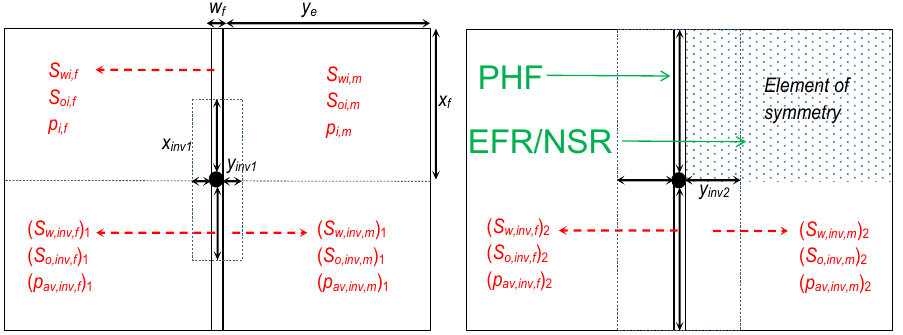
Figure 1. Conceptual model used by Clarkson et al. [12] for the tight oil DDA model. The conceptual model assumes that each hydraulic fracturing stage has a primary hydraulic fracture, containing most of the proppant, and two reservoir regions, adjacent to the primary hydraulic fracture. Modified from Clarkson et al. [43].